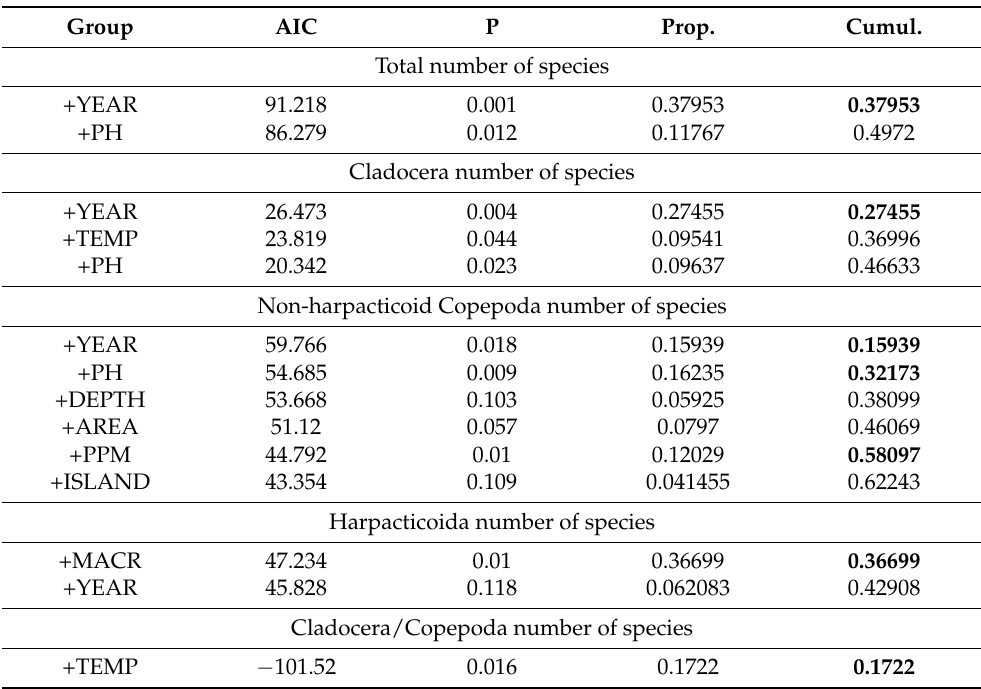
Table 2. The results of sequential test of DistLM (AIC criterion, step-wise selection). Significant factors are in bold ( p < 0.02).